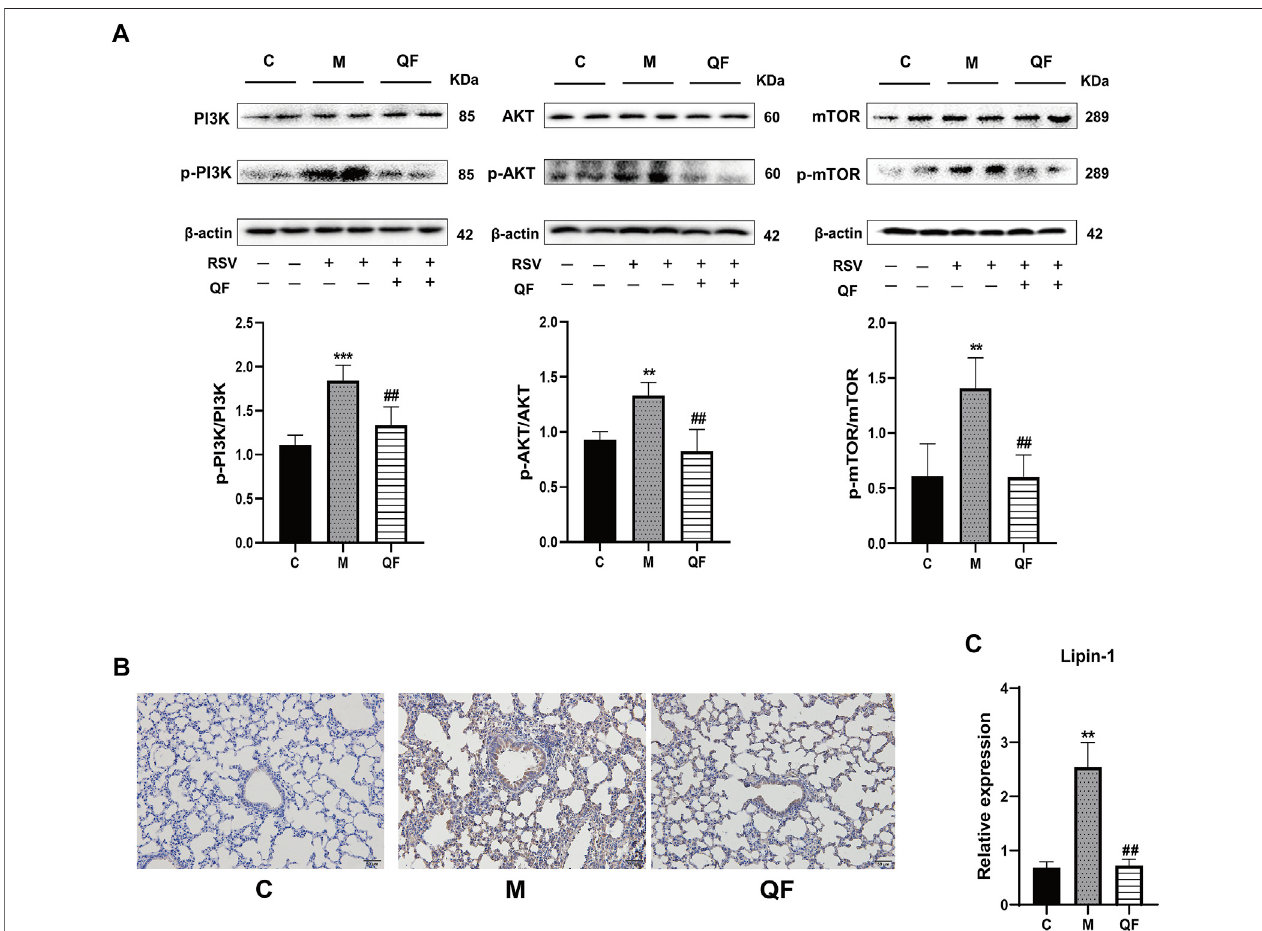
FIGURE 6 | Effect of QF on the activity of the PI3K/AKT/mTOR/Lipin-1 signaling pathway in lung tissues of mice with RSV-induced lung in fl ammation. (A) Protein expression of phosphatidylinositol 3-kinase (PI3K), phospho-phosphatidylinositol 3-kinase (p-PI3K), protein kinase B (AKT), phospho-protein kinase B (p-AKT), mammalian target of rapamycin (mTOR), phospho-mammalian target of rapamycin (p-mTOR), and β -actin in control (C), model (M), and therapy (QF) groups. The densitometry value of each phosphorylated protein was normalized against its total abundance. Values are expressed as mean ± SEM ( n (cid:1) 4; * compared with control group, # compared with model group, ** p < 0.01, *** p < 0.001, ## p < 0.01). (B) Immunohistochemical staining of Lipin-1 protein in lung tissues ofmicein control (C), model (M), and therapy(QF) groups (200 × magni fi cation). (C) mRNA expression level oflipin-1 protein in control (C),model (M), and therapy(QF) groups. Compared with control group, # compared with model group. ** p < 0.01, ## p < 0.01. Abbreviations: QF, Qingfei oral liquid; RSV, respiratory syncytial virus.